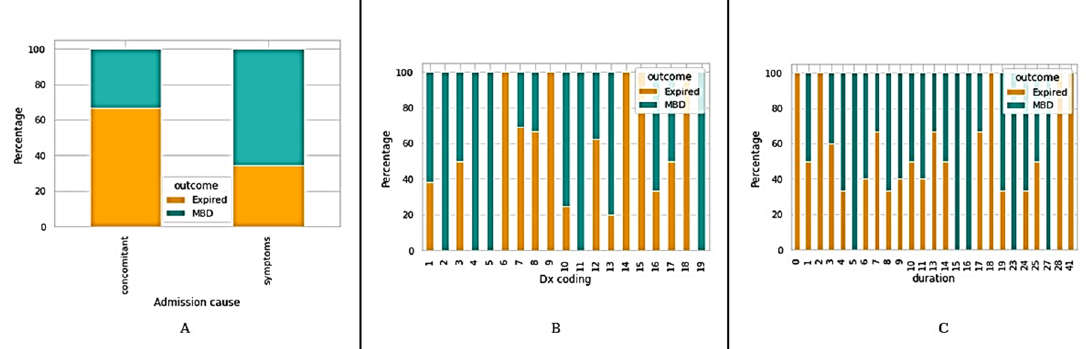
Figure 3. Classification of patients based on ( A ) admission cause, ( B ) diagnosis coding, ( C ) dura- tion.